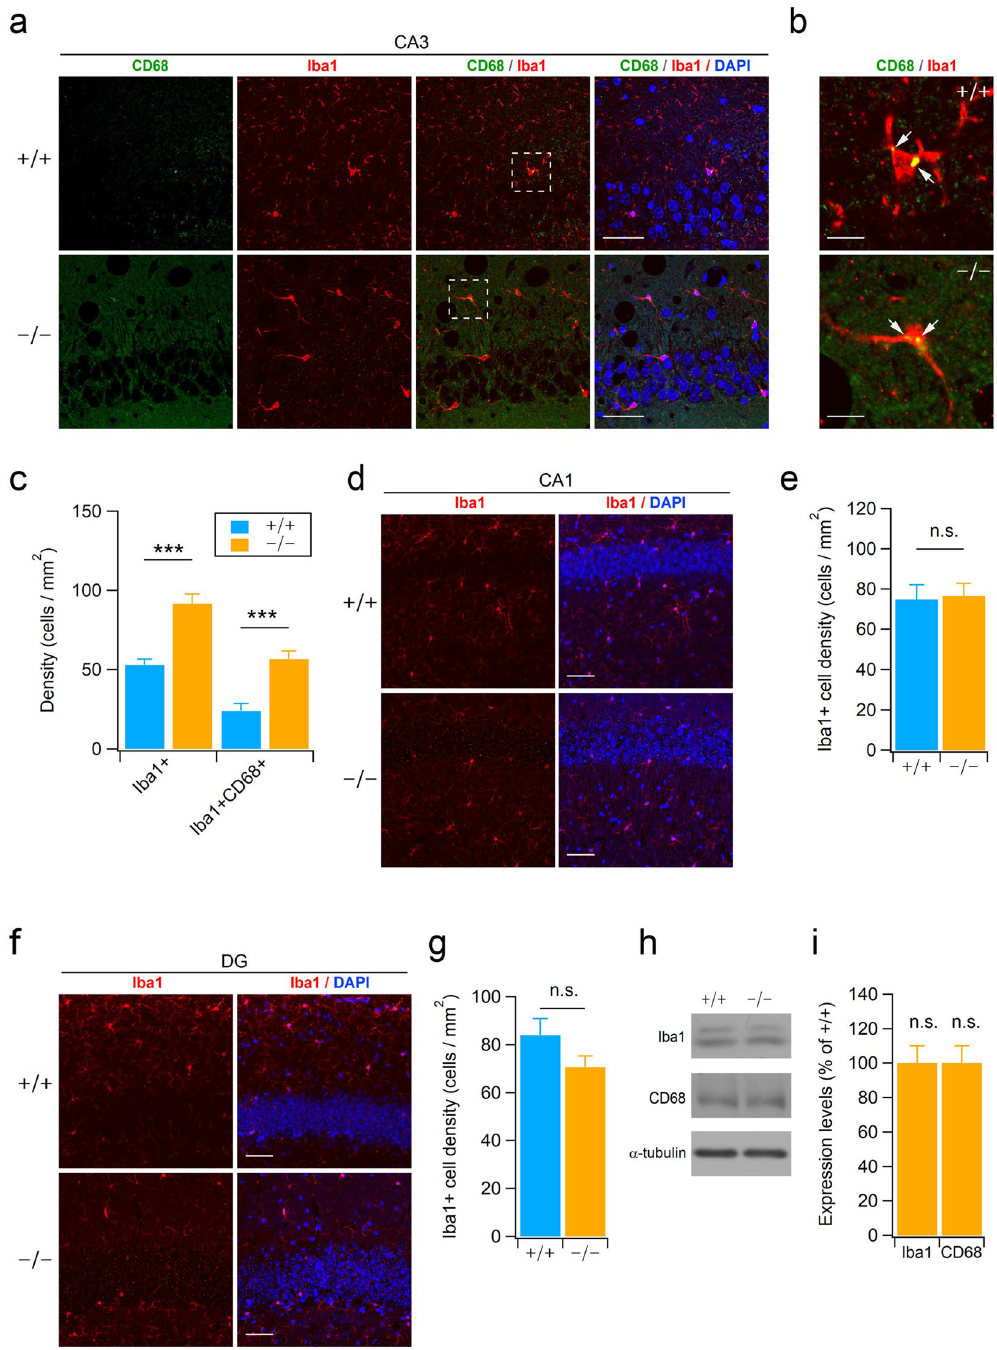
Figure 6. The density of microglia was increased in the Xpnpep1 −/− CA3 area. ( a ) Representative images of hippocampal CA3 regions stained with CD68 and Iba1 antibodies showing a higher number of microglia in Xpnpep1 −/− (bottom) than WT (top) mice. Scale bars, 50 µm. ( b ) Higher magnification views of areas indicated by the dotted white box in panel ( a ) show morphological features of normal resting microglia in both Xpnpep1 +/+ (top) and Xpnpep1 −/− (bottom) mice. Scale bars, 10 µm. Note the punctate immunoreactive signals of CD68 (arrows) near the cell body but not the processes of microglia. ( c ) Increased density of microglia in the Xpnpep1 −/− CA3 region. n = 6 slices from 3 mice per genotype. U = 82 (Iba1+) and 102.5 (Iba1+CD68+), Z = − 4.39 (Iba1+) and − 3.97 (Iba1+CD68+), *** p < 0.001 by Mann–Whitney test. ( d ) Microglia in the hippocampal CA1 area were immunostained with Iba1 antibodies (left) and merged (right) with DAPI signals. Scale bars, 50 µm. ( e ) Quantification of Iba1-positive cell density in hippocampal CA1 subfields. n.s., not significant. t (10) = − 0.17, p = 0.87 by Student’s t -test. ( f ) Iba1-immnostained (left) and merged (right) images with DAPI staining showing normal density of microglia in the Xpnpep1 −/− (bottom) DG subfield. Scale bars, 50 µm. ( g ) The density of microglia in the hippocampal DG is not changed by aminopeptidase P1 deficiency. n.s., not significant. t (10) = 1.59, p = 0.13 by Student’s t -test. ( h , i ) Western blot images ( h ) and quantification ( i ) of Iba1 and CD68 proteins in the hippocampal lysates. n = 4 pairs. α-tubulin was used as a loading control for western blotting. t (6) = − 0.21 (Iba1) and − 0.81 (CD68), p = 0.84 (Iba1) and 0.45 (CD68) by Student’s t -test. n.s., not